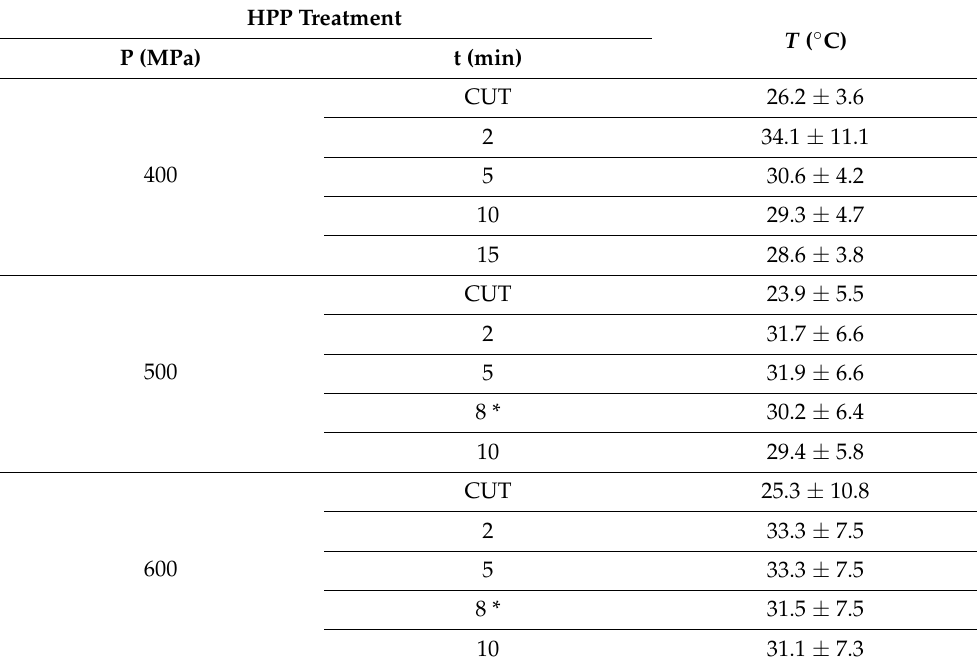
Table 3. Average temperature ( T ) during the high-hydrostatic-pressure treatment of milk. Initial water temperature, 21.6 ± 1.6 ◦